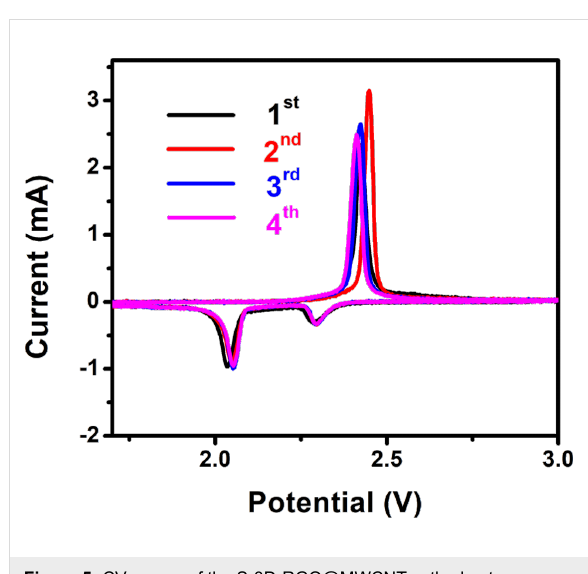
Figure 5: CV curves of the S-3D-RGO@MWCNT cathode at 0.1 mV·s − 1 in the first four